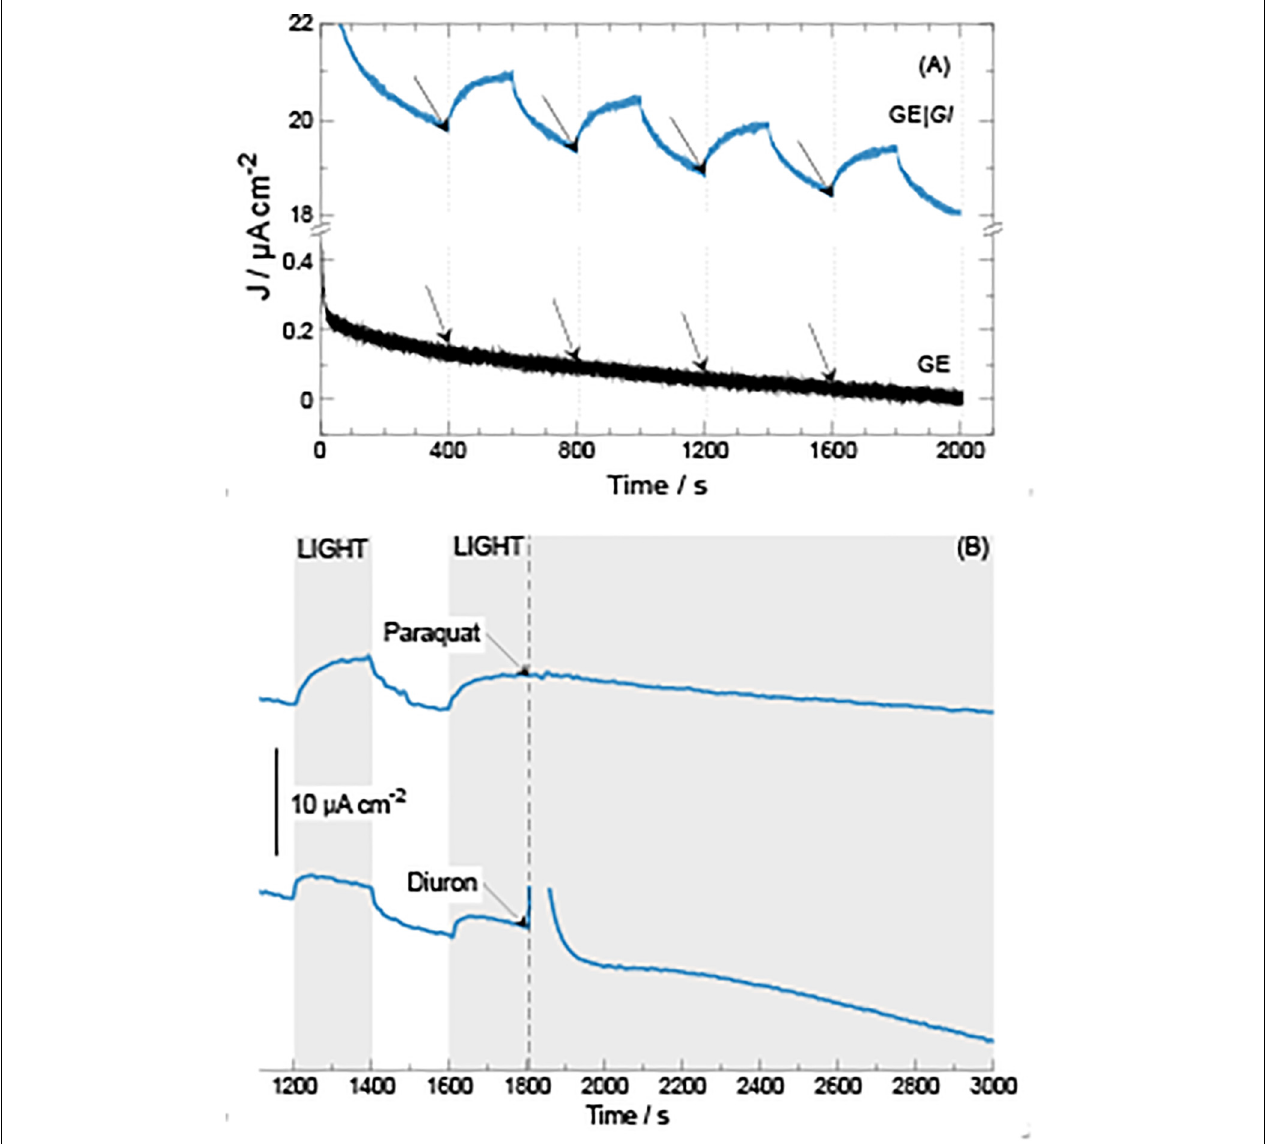
FIGURE 4 | Current density generation over time during chronoamperometric tests at 0.40 V vs Ag| AgCl| KCl 3.5 M at GE| Gl electrodes. (A) Application of consecutive 200-s illumination steps. (B) Application of 200-s illumination steps followed by addition of either paraquat or diuron (20 µ mol) at 1,800 s.